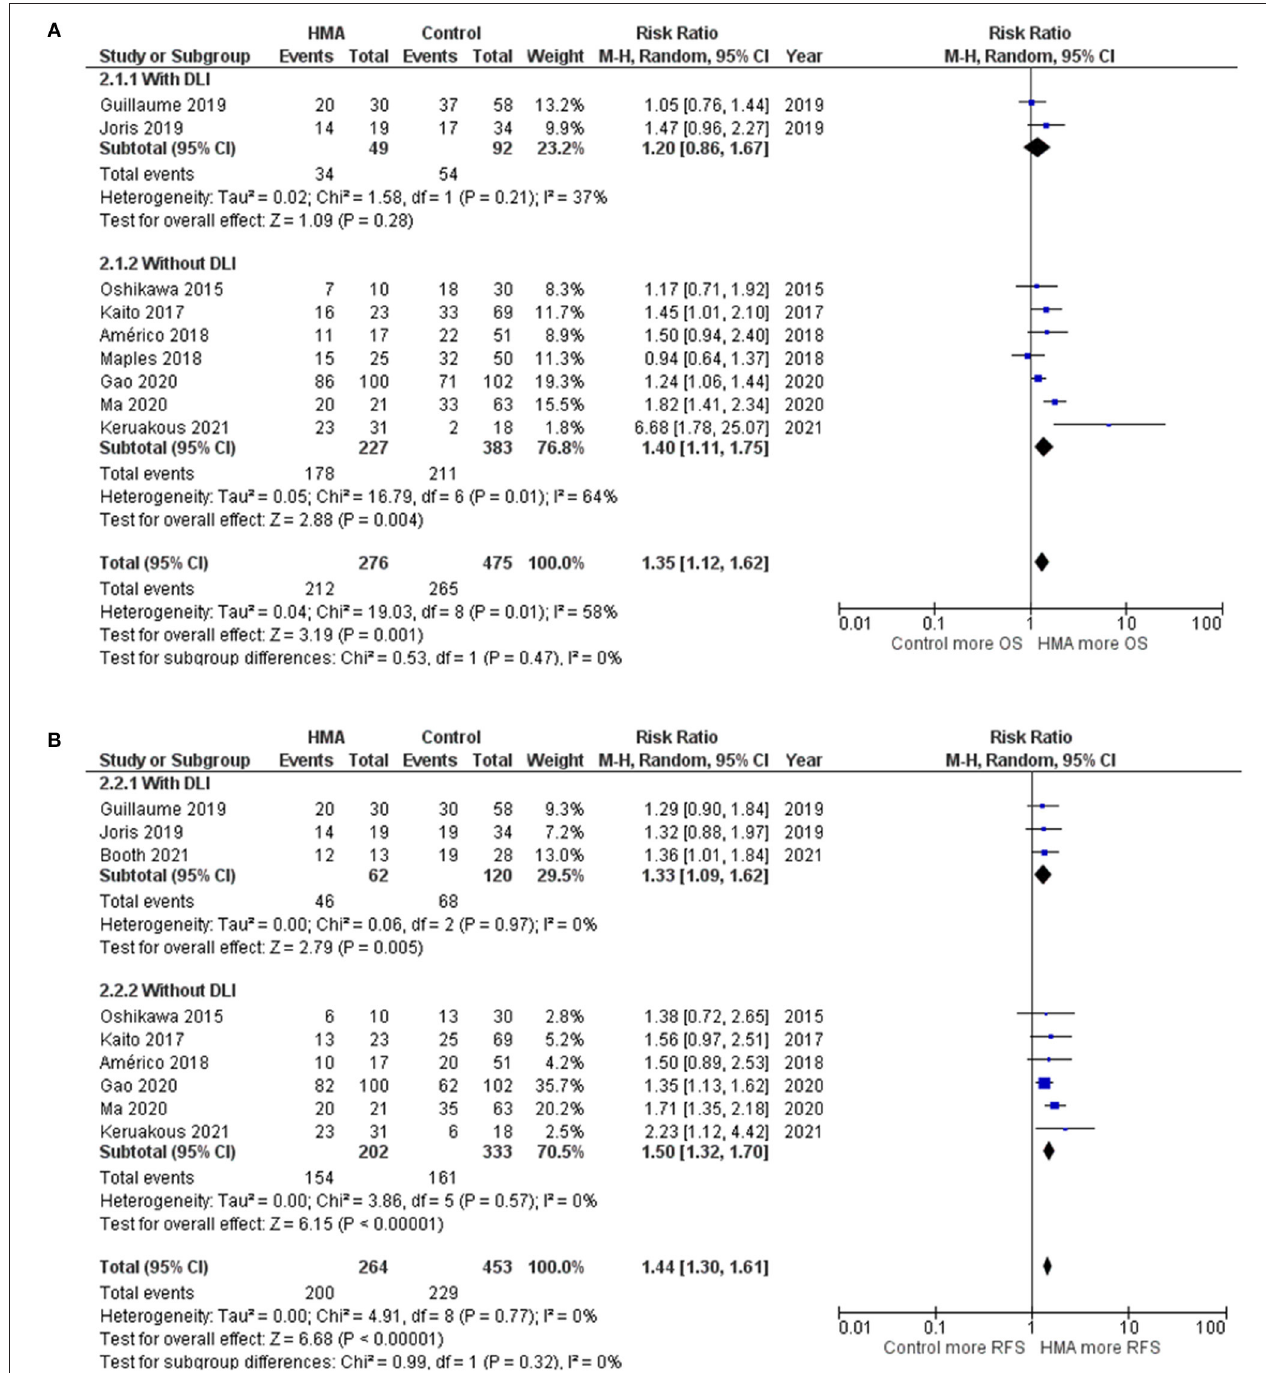
FIGURE 6 | Subgroup analysis of studies with patients receiving HMA maintenance with DLI and without DLI (A) OS rate (B) RFS